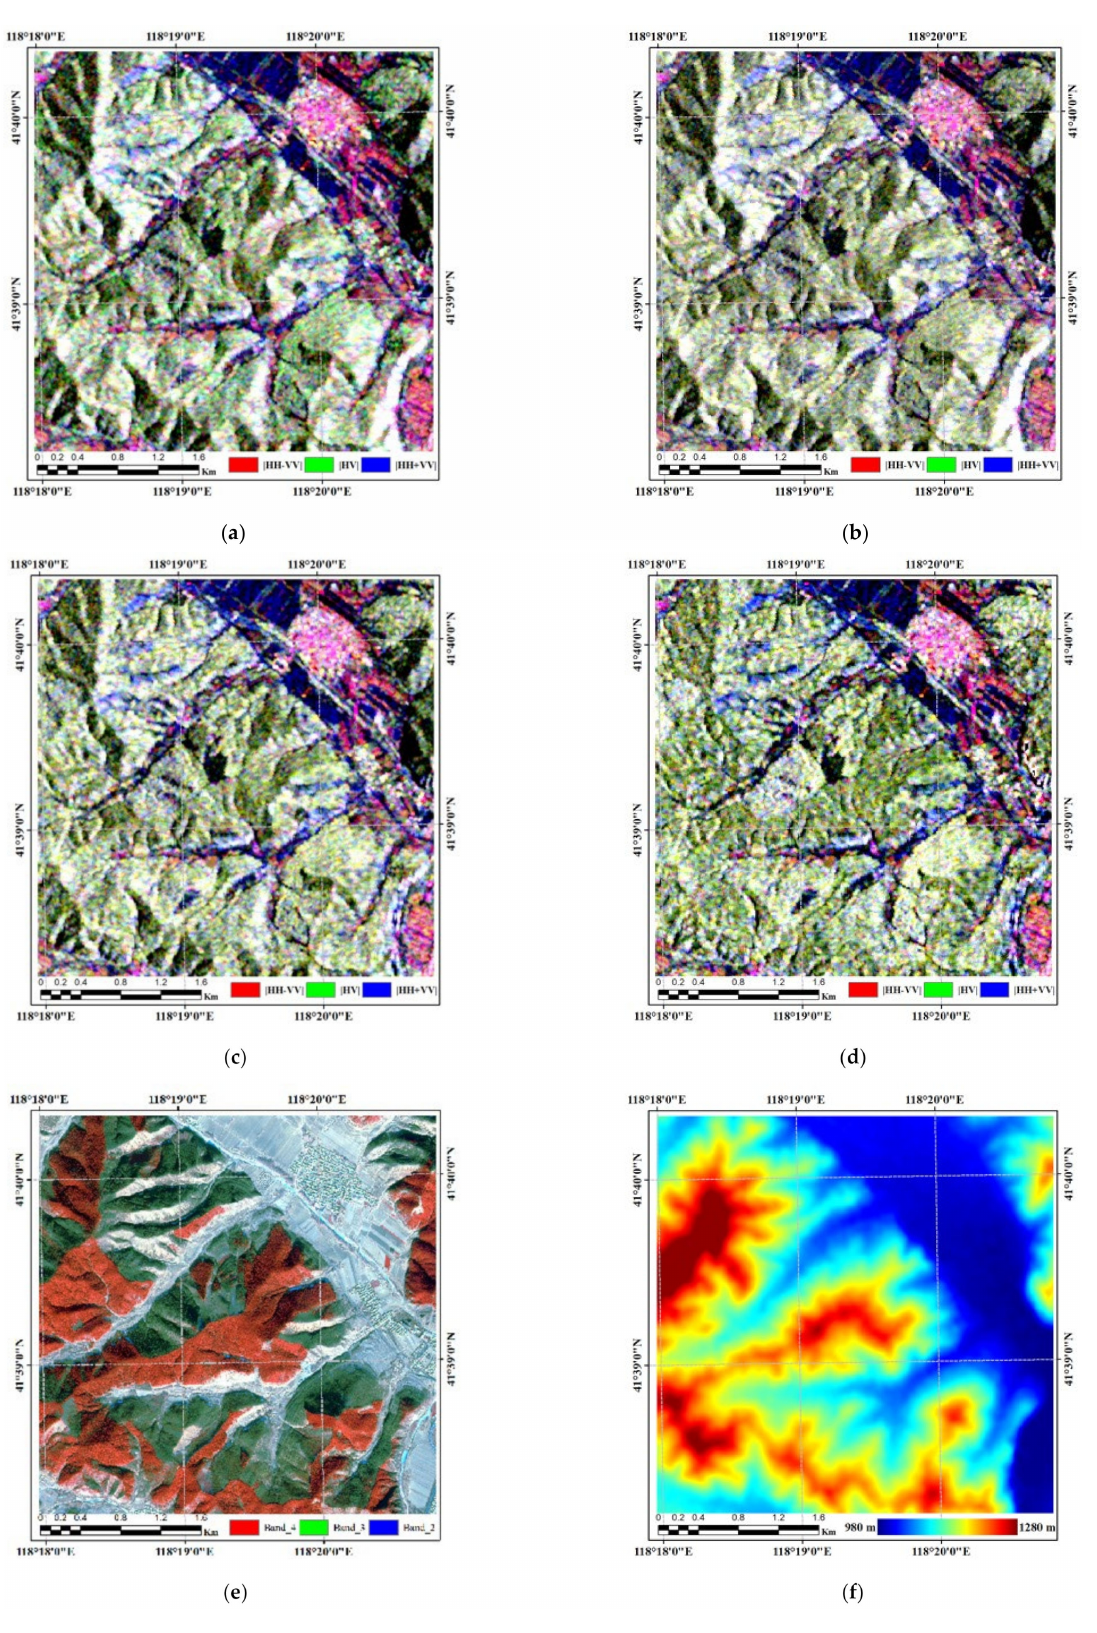
Figure 9. Enlarged image of the GaoFen-3 PolSAR Pauli RGB after each correction step, GaoFen-2 false-color combinations image, and SRTM DEM: ( a ) GTC (i.e., no correction); ( b ) POA correction; ( c ) POA + ESA correction; ( d ) POA + ESA + AVE correction; ( e ) GaoFen-2 false-color combinations image; ( f ) SRTM